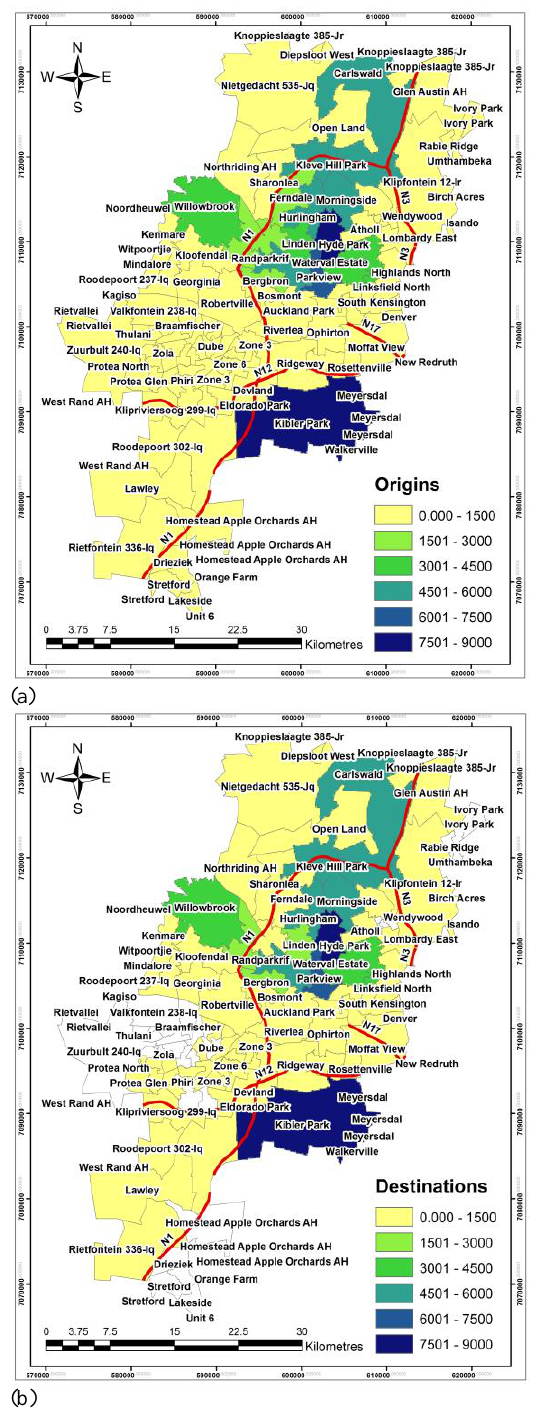
Figure 4 (a) (b): O-D polygons for cycling trips Cycling is a short distance means of transport and therefore considering the sizes of the Strava data polygons, some cycling trips started and ended within the same polygon. The maps above also indicate that most polygons have higher number of trips origins than the number of trip destinations. It is also indicated that except Kibler Park at the south eastern part Johannesburg, most of the suburbs with higher cycling O-D’s are from the centre of the city towards the north of the city and some on the